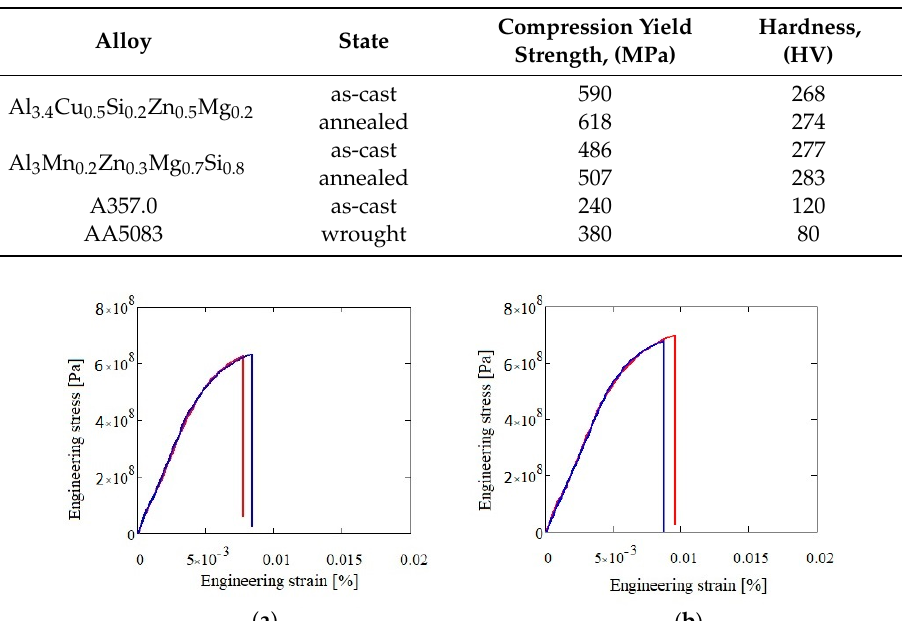
Figure 22. Compression test results for as-cast ( a ) and heat treated ( b ) Al 3.4 Cu 0.5 Si 0.2 Zn 0.5 Mg 0.2 alloy.